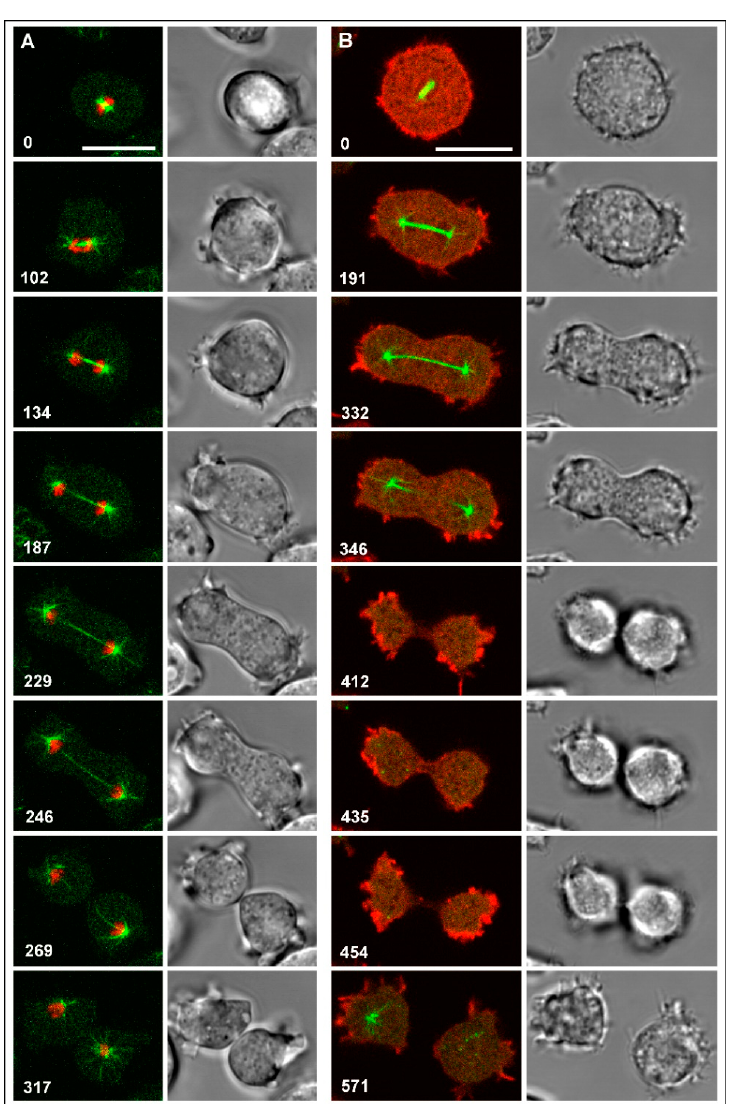
Figure 1. Mitosis and cytokinesis in wild-type cells of Dictyostelium discoideum . The left panels in the time series of ( A ) and ( B ) show confocal dual-color fluorescence images, the right panels show DIC bright-field images. Time after the first frame of each series is indicated in seconds. Scale bars, 10 µm. ( A ) A cell expressing GFP- α -tubulin as a label for the mitotic apparatus (green) and mRFP-histone 2B to visualize the chromosomes (red). The elongated spindle is disrupted between the 246 s and 269 s frames. The 317 s frame shows in the right cell radial microtubules connecting the centrosome with the cell cortex. ( B ) A cell expressing GFP- α -tubulin (green) and mRFP-LimE Δ as a label for filamentous actin (red). Fluorescence images are primarily focused on the spindle or on polar protrusions; for the 435 s frame, the focus was changed to the cleavage furrow, where little actin had accumulated. The cell was flattened by agarose overlay. The same sequence is shown in supplementary Video S1. For a 3D display showing polar protrusions attached to the substrate surface, see supplementary Video S2.